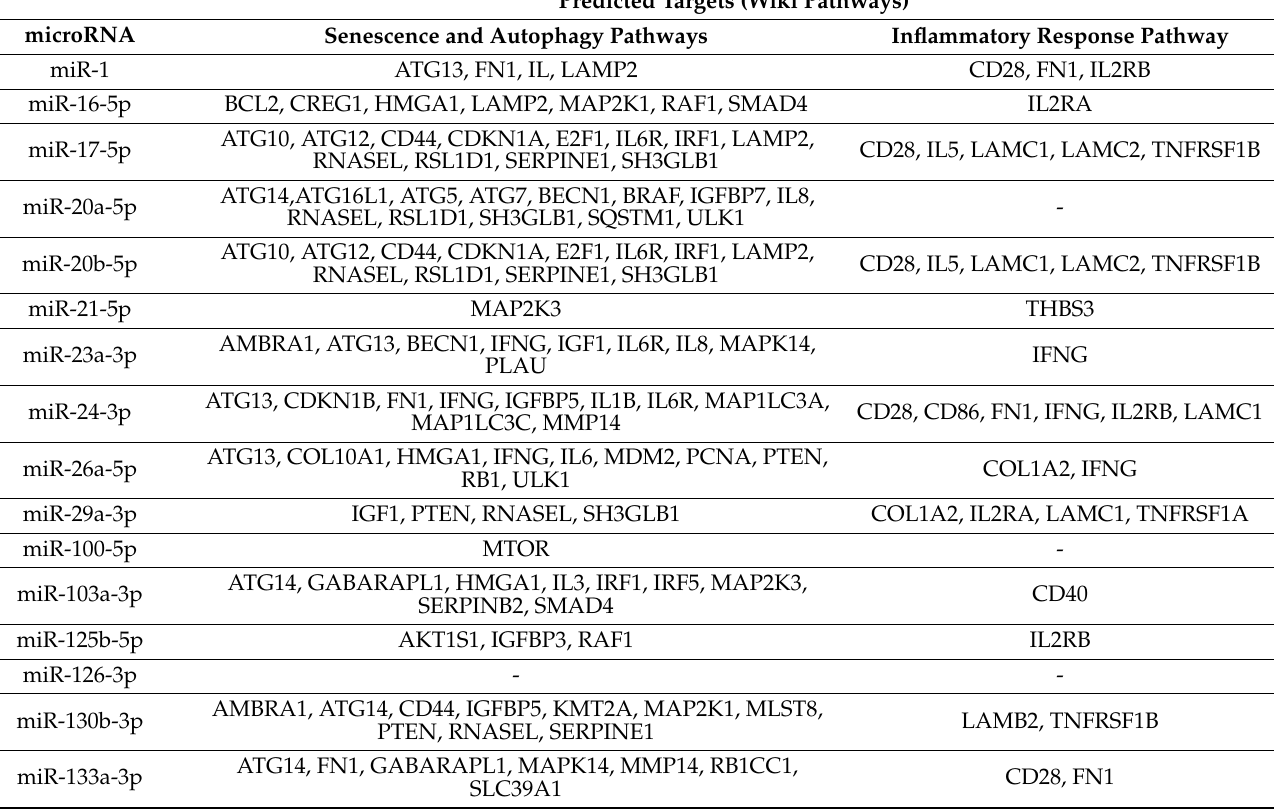
Table 6. A list of predicted targets of microRNAs dysregulated in the whole peripheral blood of preterm-born children in relation to the senescence and autophagy pathways and the inflammatory response pathway, using the miRWalk2.0 database (data available in Wiki